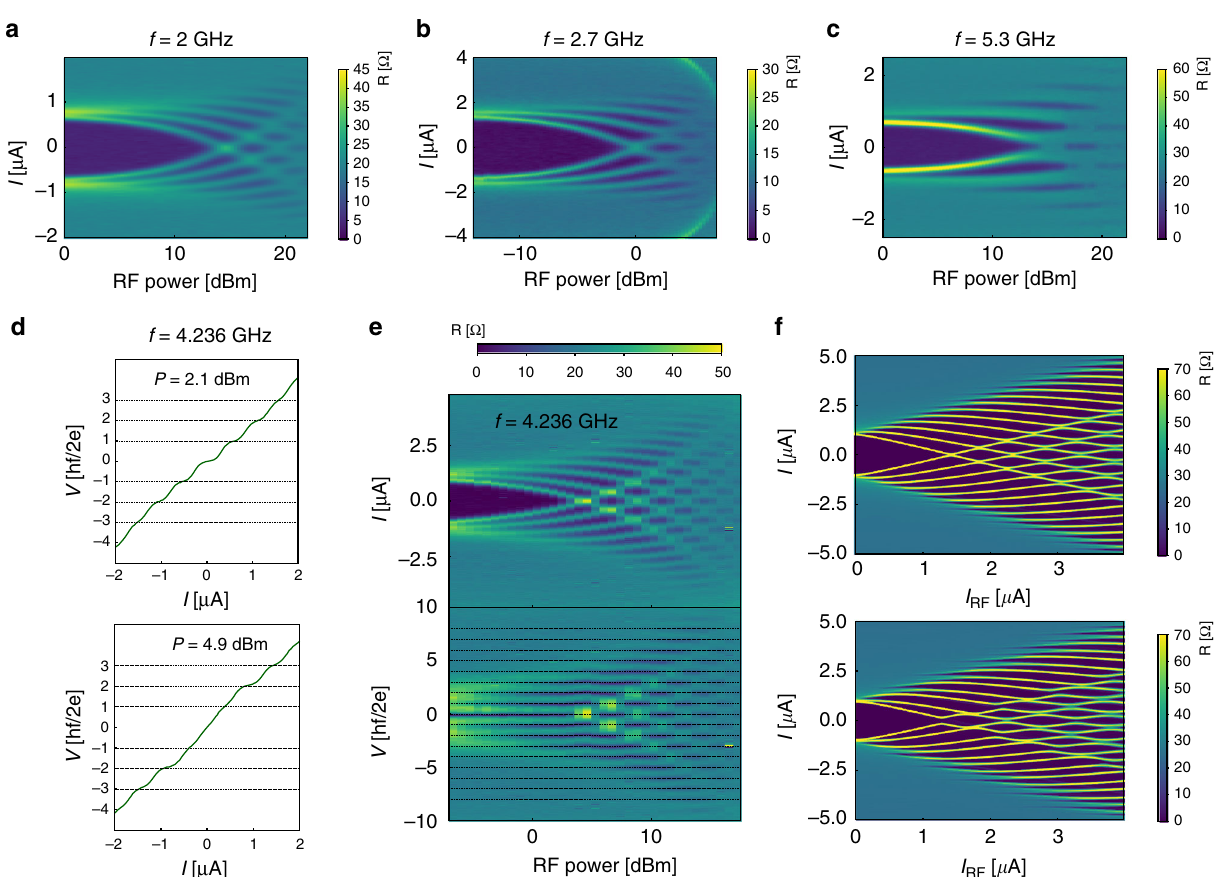
Fig. 2 A.C. Josephson effect in Bi 2 Se 3 . For this Josephson junction, 50 nm thick Aluminum electrodes are used. a – c Resistance maps as a function of current and RF power for different microwave frequencies (a) f = 2 GHz, (b) 2.7 GHz, and (c) 5.3 GHz. The zero resistance regions correspond to voltage plateaus. d IV curves showing the Shapiro steps for two values of the microwave power. The n th current step appears at a voltage V n ¼ nhf function of current (upper panel) or voltage (lower panel) and RF power at the frequency f = 4.236 GHz. In the lower panel as a function of voltage, dashed lines are plotted at V n ¼ nhf . f Theoretical maps calculated at f = 4.236 GHz with the RSJ model, see Supplementary Note 2, using two different CPRs: a 2 e conventional 2 π periodic CPR I J = I c sin( φ ) is used for upper panel, it reproduces properly the experimental data. An unconventional CPR I